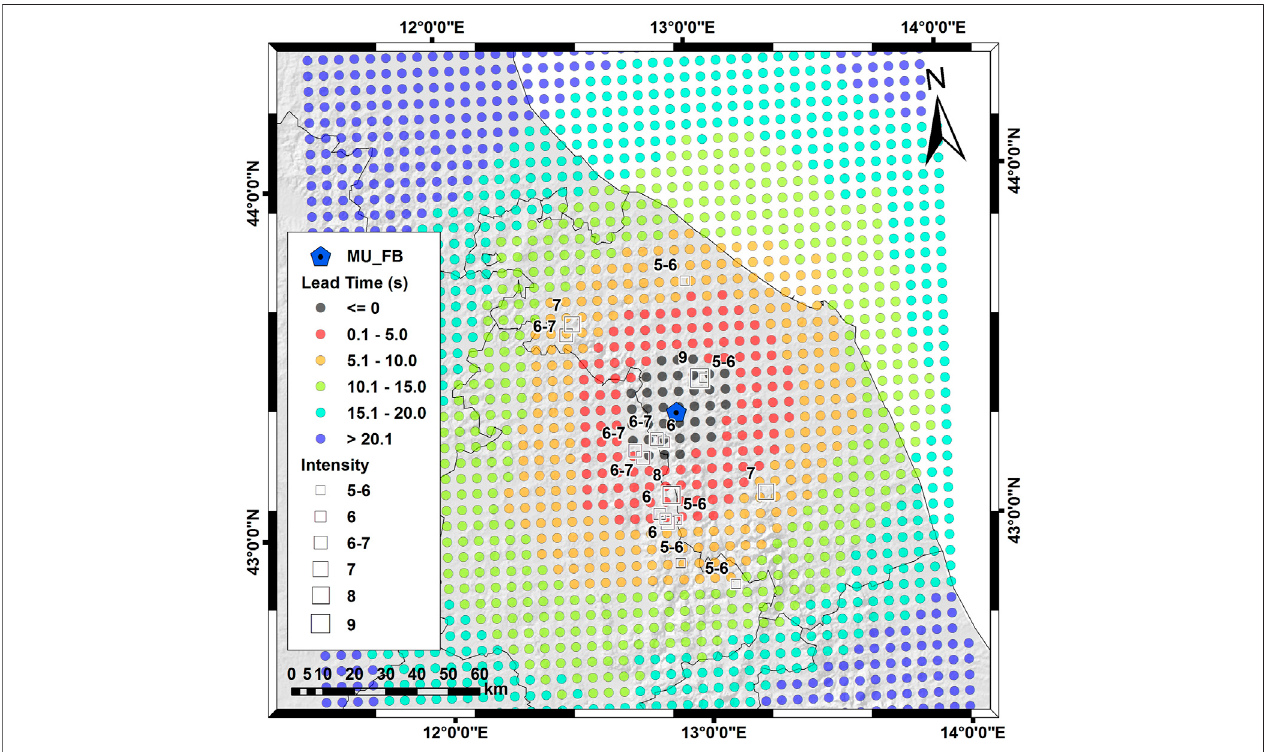
FIGURE 7 | LT mapping for city of Fabriano and historical destructive earthquake. Blue pentagon: place of city of Fabriano (MU_FB target). Colored circles: values of LT in seconds. Squares: CPTI15 v3.0 historical earthquakes and macroseismic intensity (DBMI15 v3.0, Locati et al., 2021) estimated for the city of Fabriano.